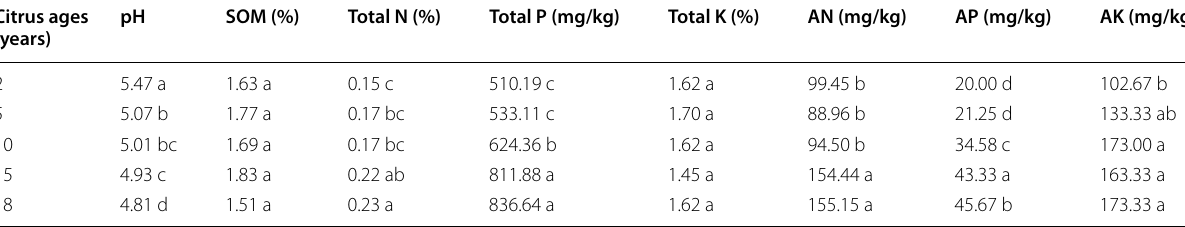
Different letters in the same column indicate significant difference between citrus ages at 0.05 level. The same below